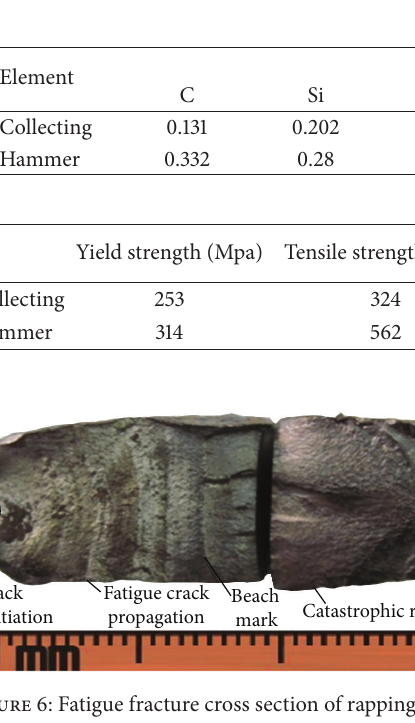
test is given in Table 2. The hammer material is steel Ck35 and formed and produced by forging operation.